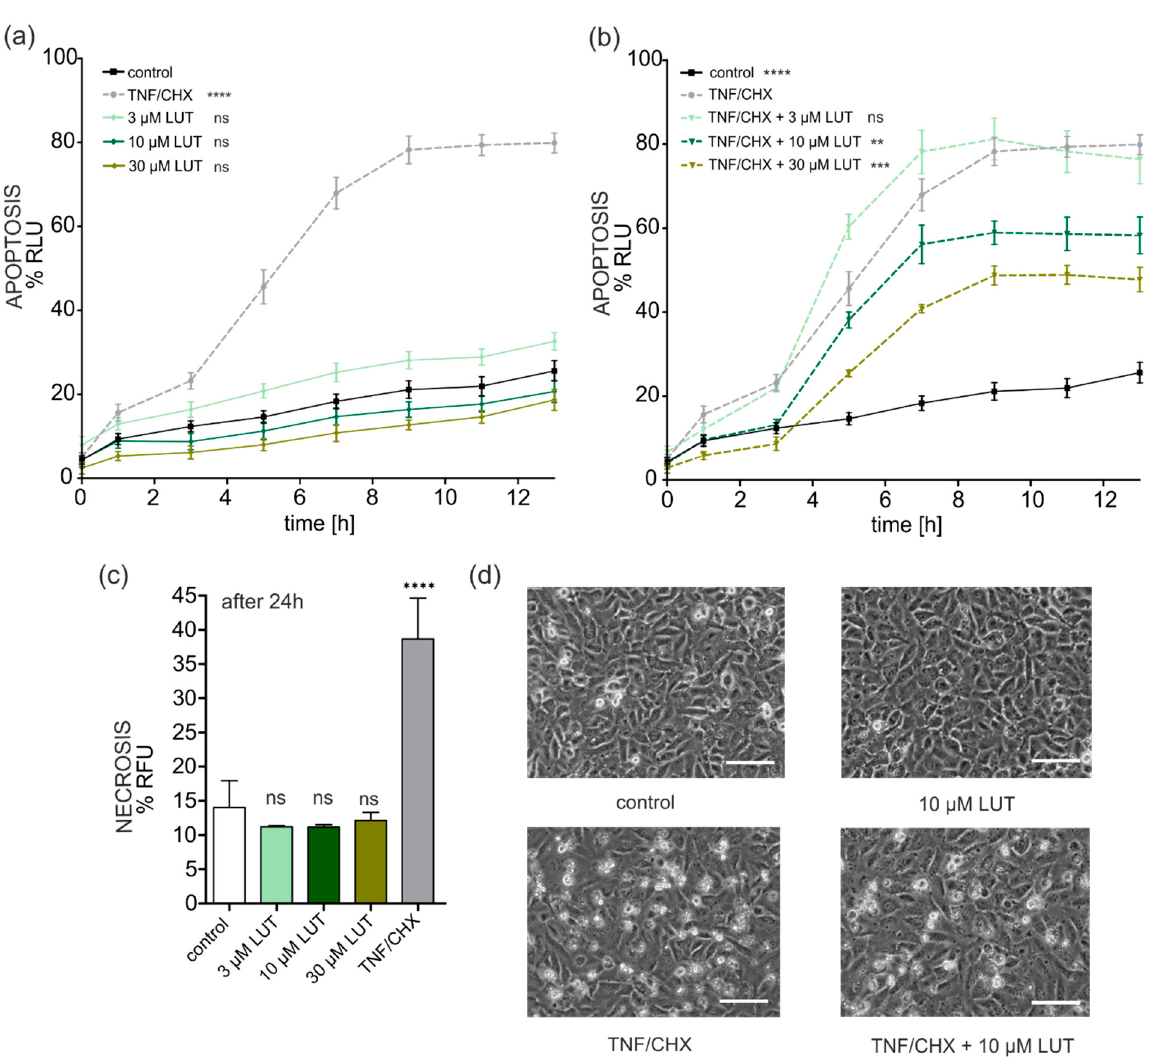
Figure 5 . Protective effects of LUT against damage caused by TNF- α with cycloheximide. ( a ) Effect of LUT on apoptosis of EA.hy926 cells. The results of experiments under control conditions, after the addition of 3, 10 and 30 μ M LUT in relation to the inducer of apoptosis in endothelial cells—TNF/CHX, are presented (% RLU-relative luminescence units; corresponded to the signal of apoptosis). Statistical significance levels relative to control were determined using a two-way ANOVA with Tukey’s test for n = 3 ( p < 0.0001 (****); p > 0.05 (ns)). ( b ) Protective effect of LUT on damage by TNF/CHX. The graph shows the change in luminescence over time (induction of apoptosis) under control conditions and in cells incubated with 3, 10 and 30 μ M LUT one hour before the addition of dTNF/CHX, and in damaged TNF/CHX cells. Statistical significance levels relative to the damage ddprobe were determined using the two-way ANOVA with Tukey’s test for n = 3 ( p < 0.01 (**); p < 0.001 (***); p < 0.0001 (****); p > 0.05 (ns)). ( c ) Effect of LUT on induction of necrosis in EA.hy926 cells after 24 h. The graph shows the results obtained under control conditions, 3, 10 and 30 μ M of LUT and the damage factor TNF/CHX. The level of statistical significance relative to the control was determined by one-way ANOVA with Tukey’s test for n = 3 ( p < 0.0001 (****); p > 0.05 (ns)). ( d ) Photographs showing the observed protective effect of 10 μ M LUT against TNF/CHX damage in vascular endothelial cells, taken after 24 h. Pictures of control cells treated with 10 μ M LUT, damaged by TNF/CHX and pre-incubated with 10 μ M LUT before the administration of the damaging factor (TNF/CHX) are presented. The white horizontal line in the lower right corner is 200 μ m. On the other hand, LUT emerged as a protective agent against the oxidative stress and apoptosis caused by the combination of TNF/CHX. Indeed, one hour before adding the damaging factors to the cells, they were incubated with LUT at concentrations of 3, 10